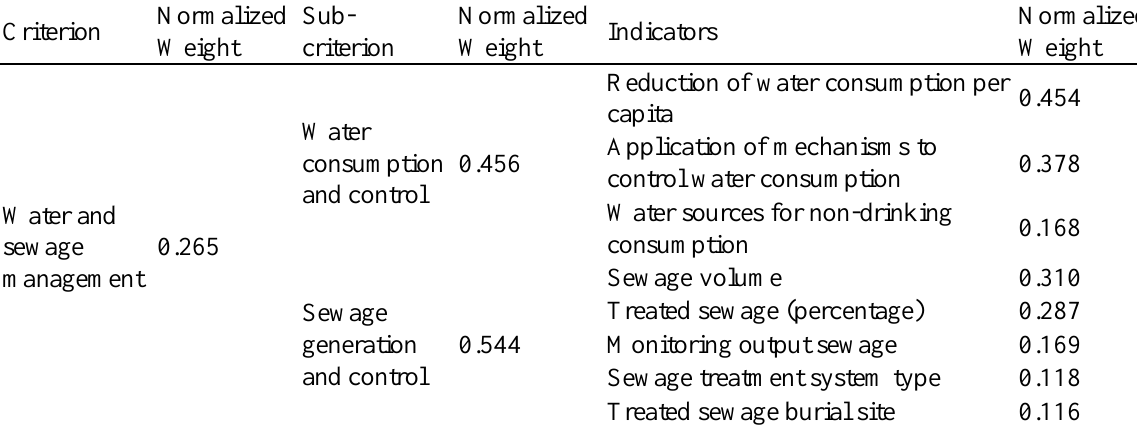
Table 3. Wastewater management sub-criteria, indicators and corresponding weights Criterion